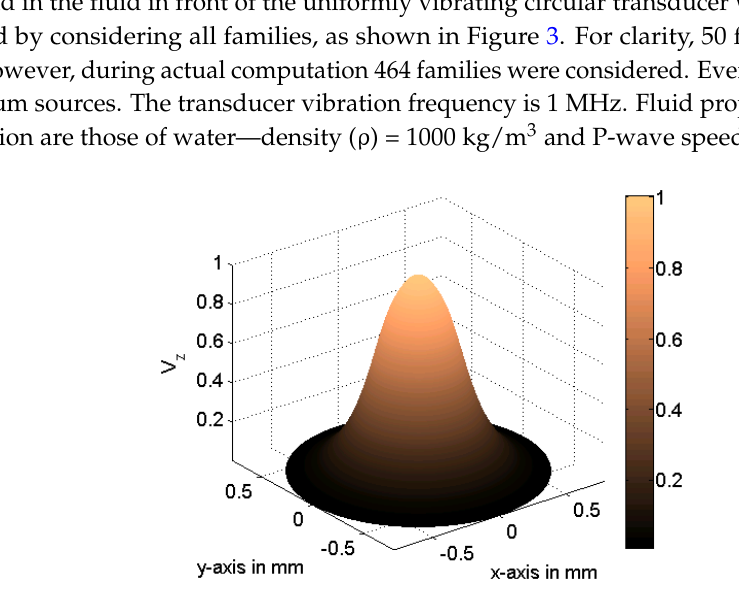
Figure 4. Normal velocity variation (or radiation pattern) from one source family.